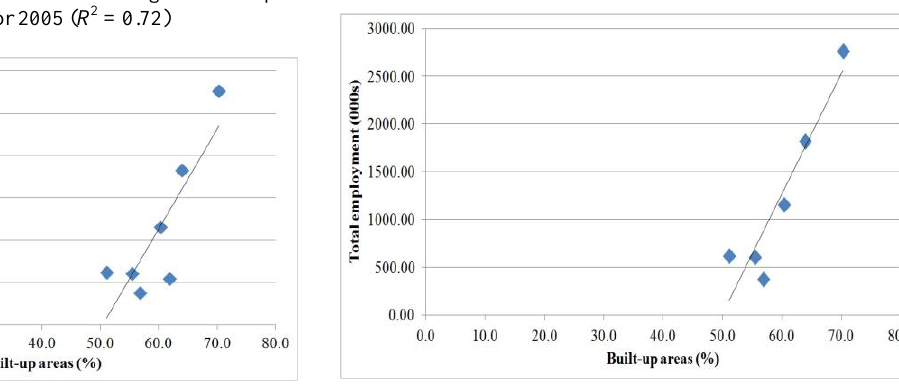
Figure 16. Relationship between the percentage of built-up areas and population without Edmonton City for 2005 ( R 2 =